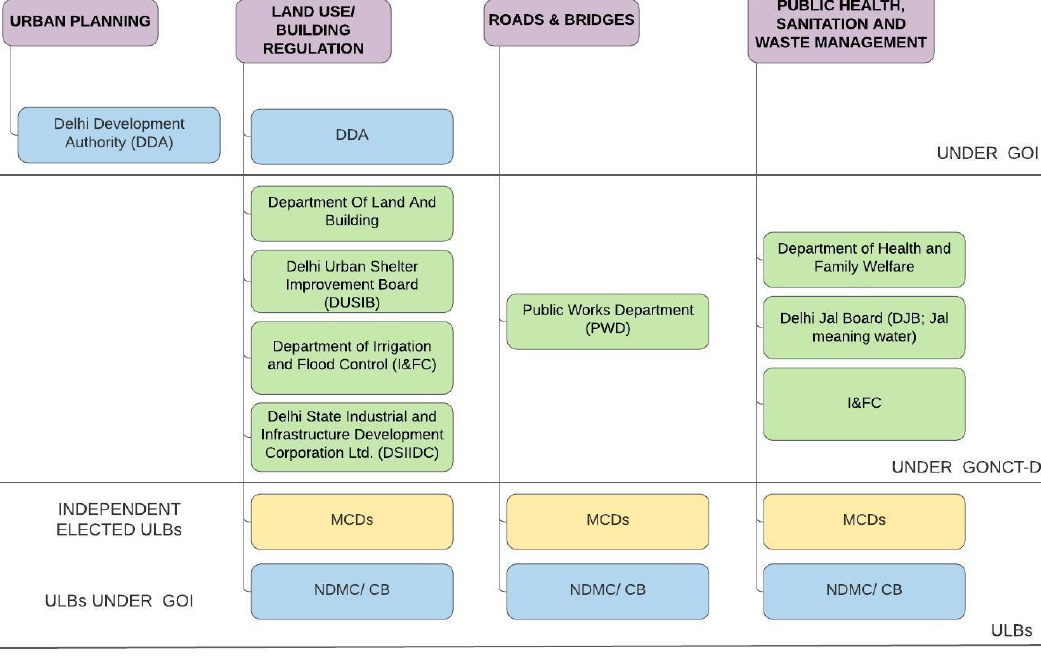
Source: Rao (2016), adapted by authors